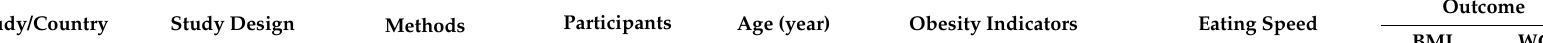
Table 3. Summary of the design and results from articles analysing the relation between eating speed and obesity indicators in subjects with noncommunicable diseases.